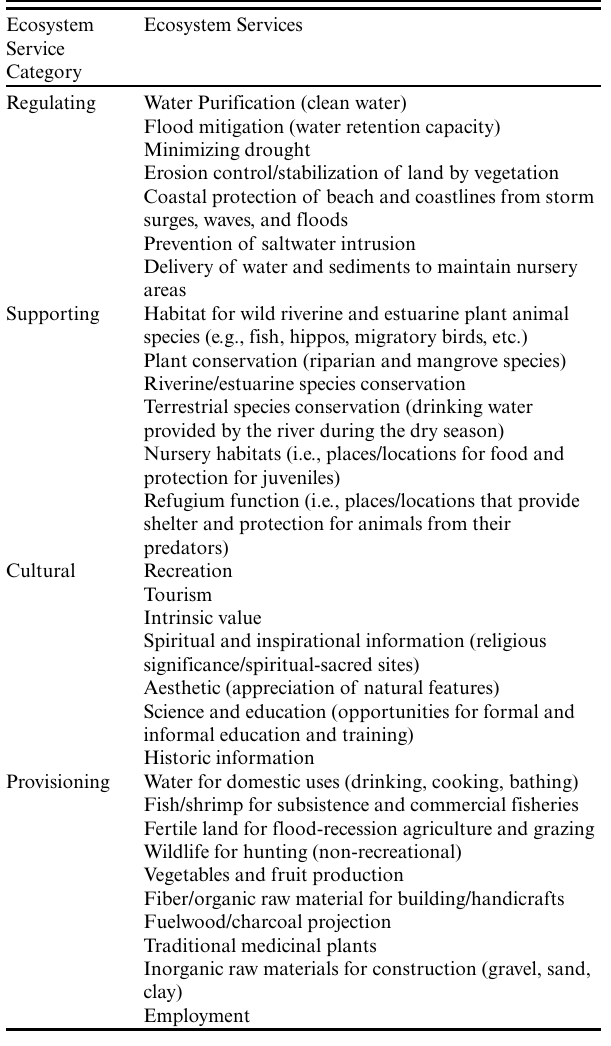
Table 1 . Ecosystem services the survey respondents were asked to